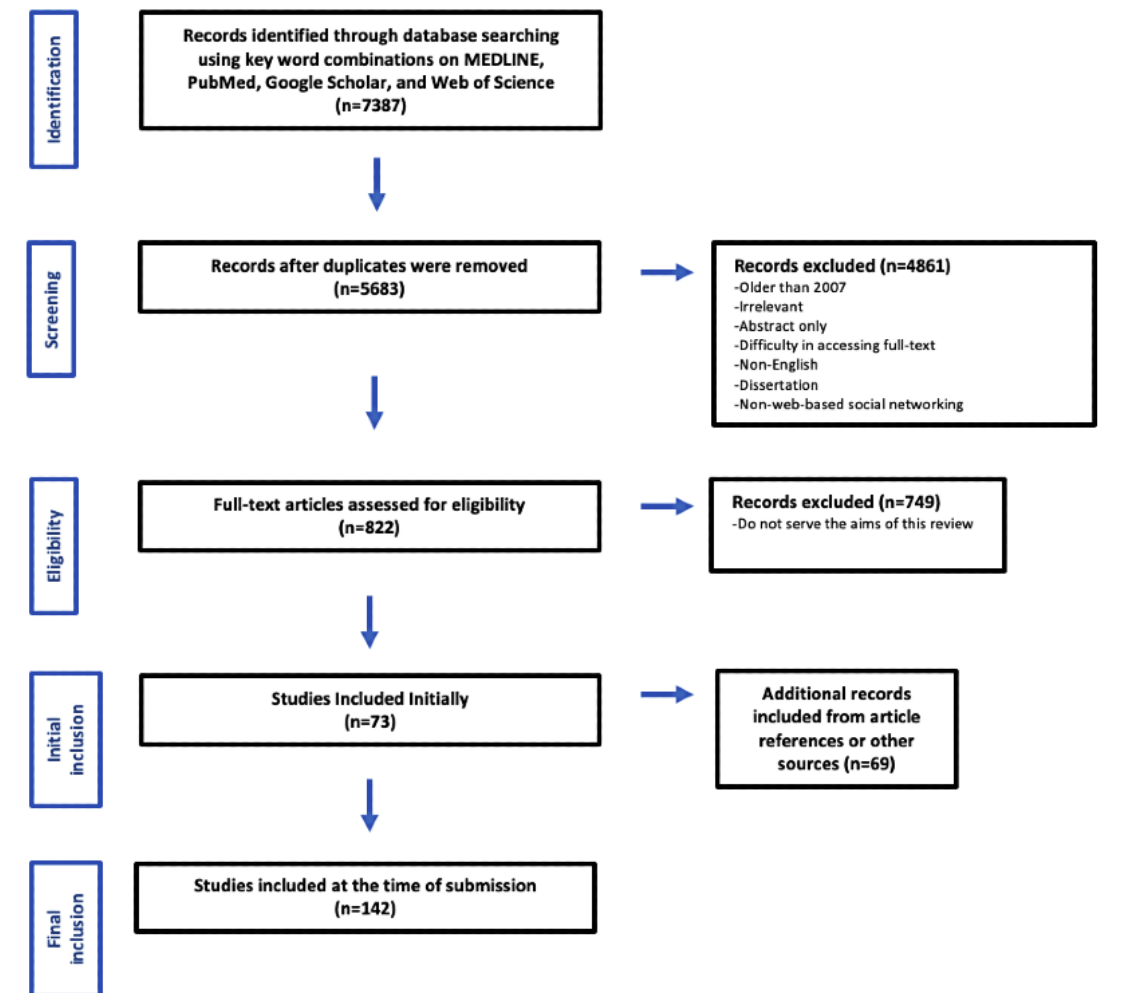
Figure 1. Flowchart of the selection